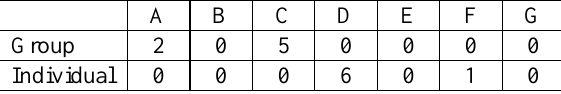
Table 5: Categorising learners’ results for problem 1 A B C D G Group Individual